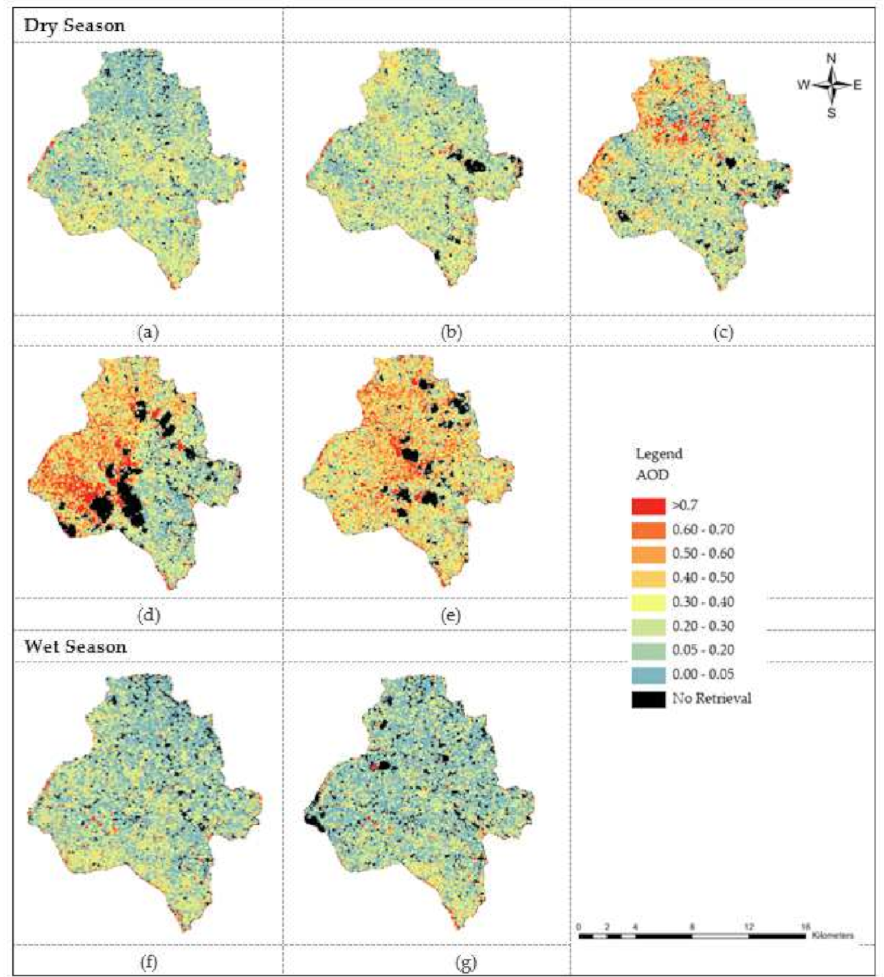
Figure 4. Estimated satellite AOD at satellite overpass time for each of the selected Landsat-8 and Sentinel-2 images. ( a – e ) AOD estimates for images acquired in the dry season, i.e., on 31 December ( f , g ) AOD estimates for images acquired in the wet season, i.e., on 21 September 2020 and 25 March 2021,